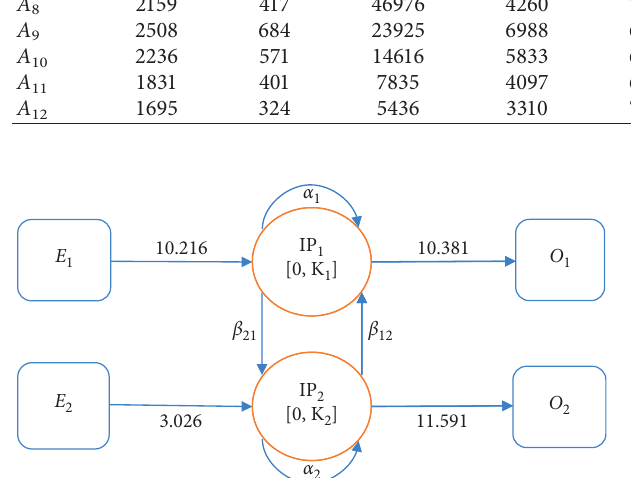
Figure 2: Interpopulation model of IP